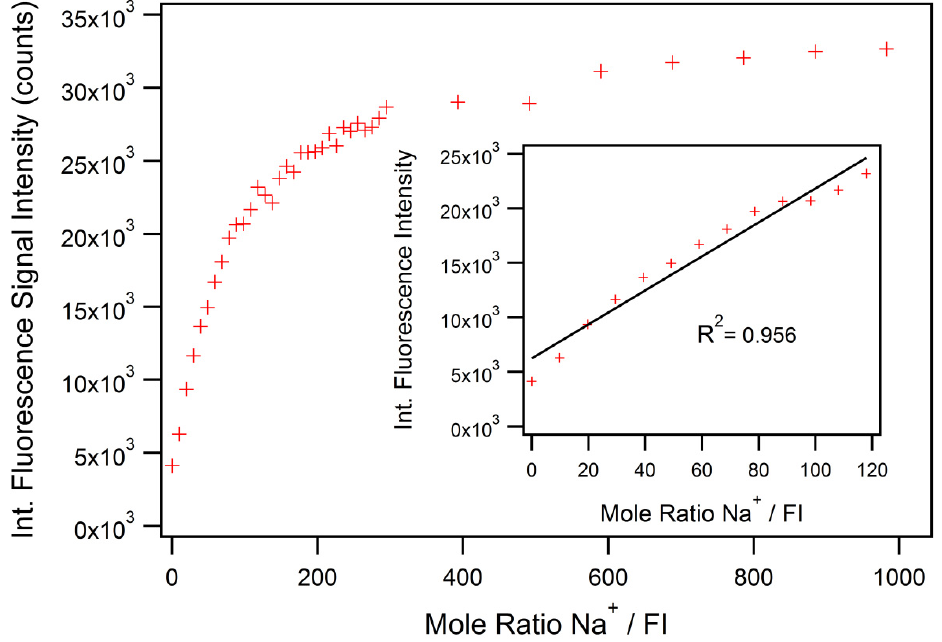
Figure 3. Integrated fluorescence intensity of different mole ratio of sodium to FI, recorded at an excitation wavelength of 470 nm. The inset shows the linear range of the PET effect including an applied linear fit with R 2 = 0.956. A constant FI concentration of 0.02 mM was used; the concentration sodium ions was